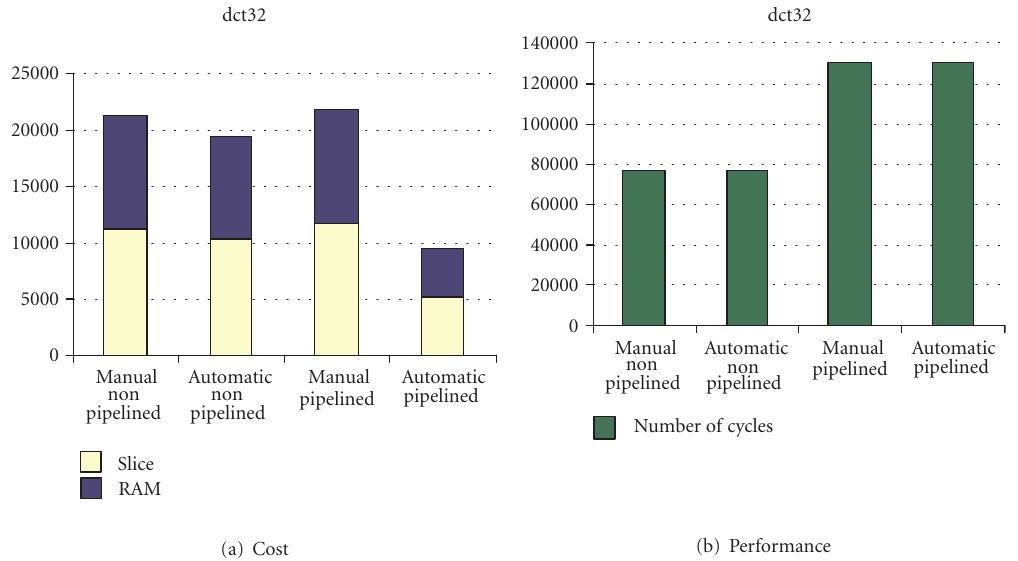
Figure 17: dct32 : number of slices, number of RAMs, and number of cycles for manually selected and automatically generated data paths.